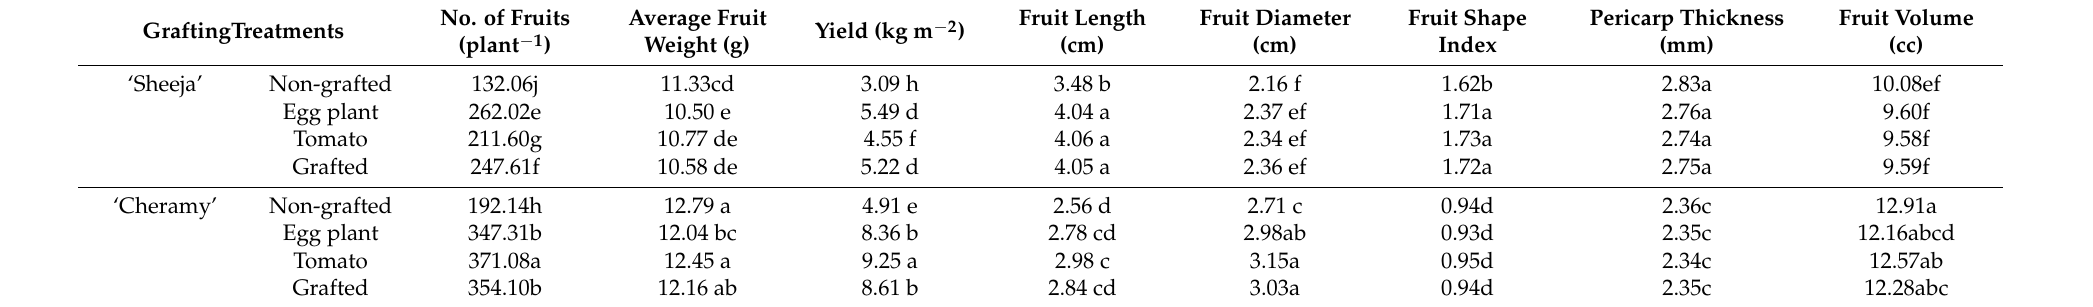
Table 6. Fruit length, diameter, shape index, pericarp thickness and volume of cherry